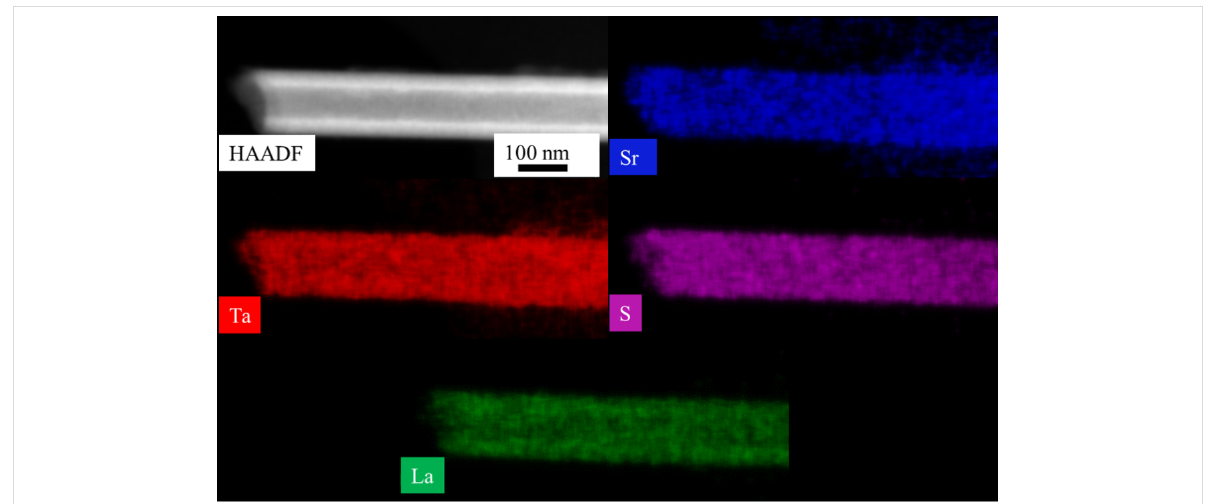
Figure 3: HAADF-STEM image (top left) and EDX elemental mapping of Sr, Ta, S, and La in a Sr x La 1 − x S–TaS 2 nanotube prepared from 10 atom % of Sr in the precursor.